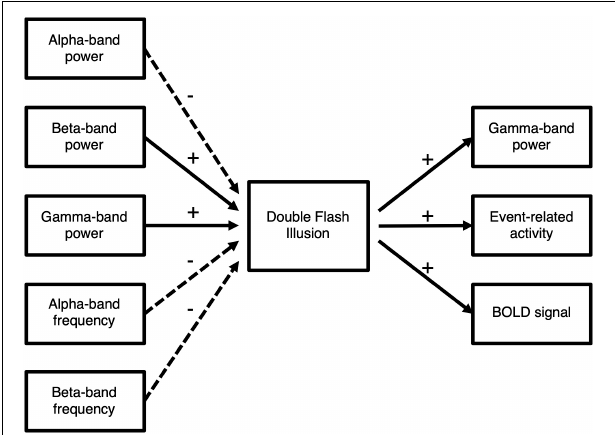
FIGURE 3 | Overview of the neural mechanisms underlying the illusion. Experimental evidence indicates that the perception of the illusion is associated with increased gamma-band power, increased evoked responses, and increased bold activity (+, solid arrows). Moreover, higher beta- and gamma-band power increase the likelihood to perceive the illusion. In contrast, lower alpha-band band power and lower alpha- and beta-band frequencies increase the likelihood to perceive the illusion (–, dashed